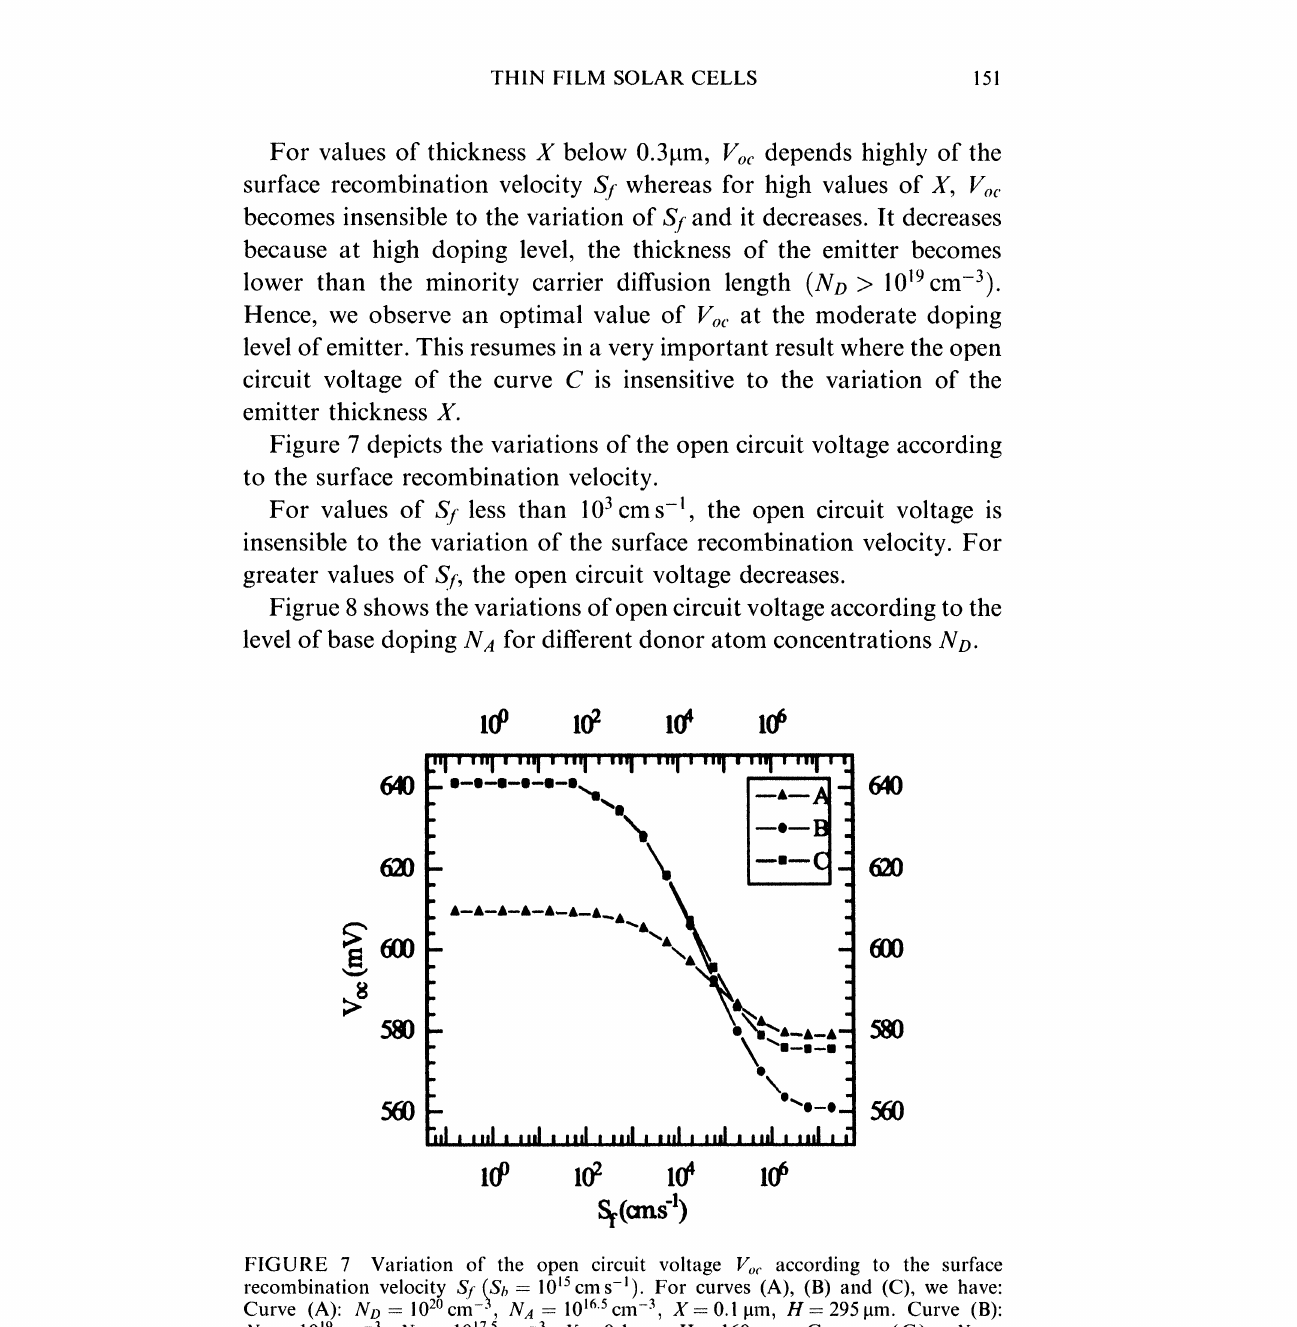
FIGURE 7 Variation of the open circuit voltage Voc according to the surface recombination velocity Sf S 1015 cms-l). For curves (A), (B) and (C), we have: 2o N Curve (A): No= 10 cm--,